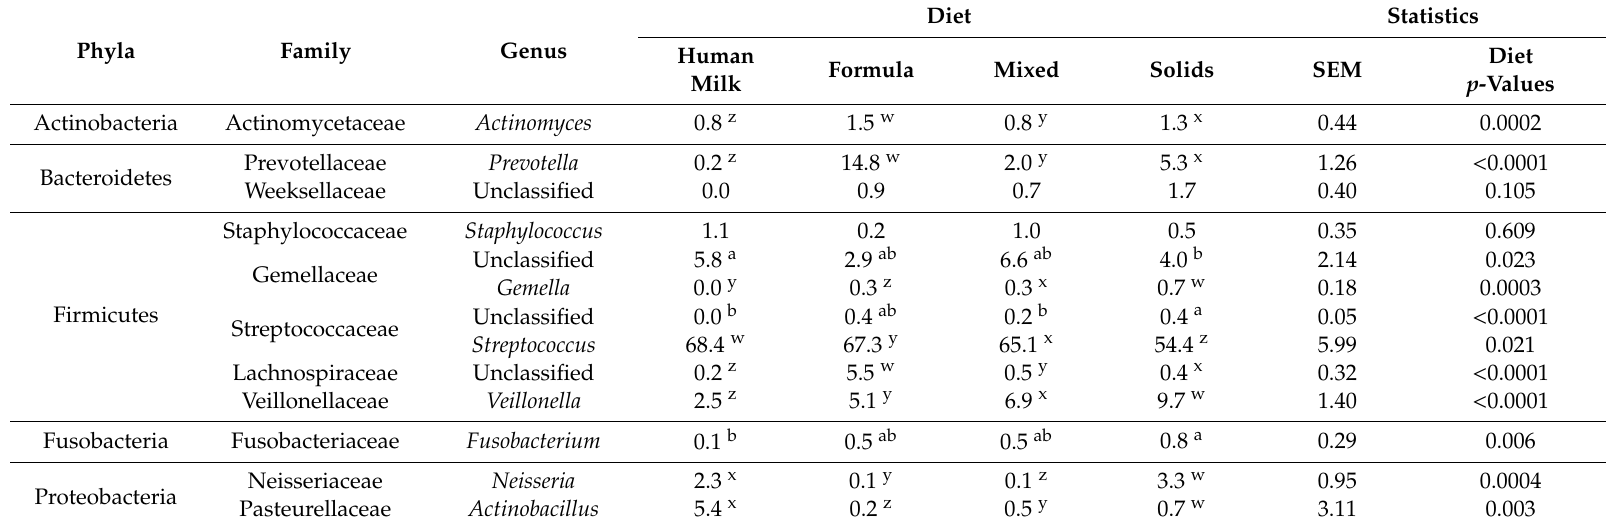
Table 6. Oral bacterial genera of infants by feeding method (% of